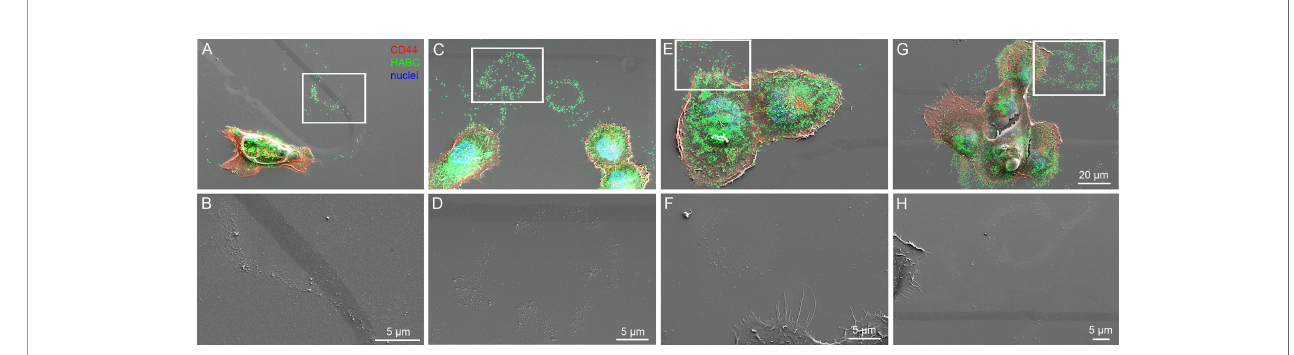
FIGURE 4 | Visualization of HA-positive trails with correlative light and electron microscopy (CLEM). Single cells or groups of cells are presented as overlay images of confocal 3D projections from CD44 and fHABC stainings and scanning electron microscopy (A, C, E, G) and high magni fi cation SEM images from the selected areas indicated by white boxes are shown in (B, D, F,